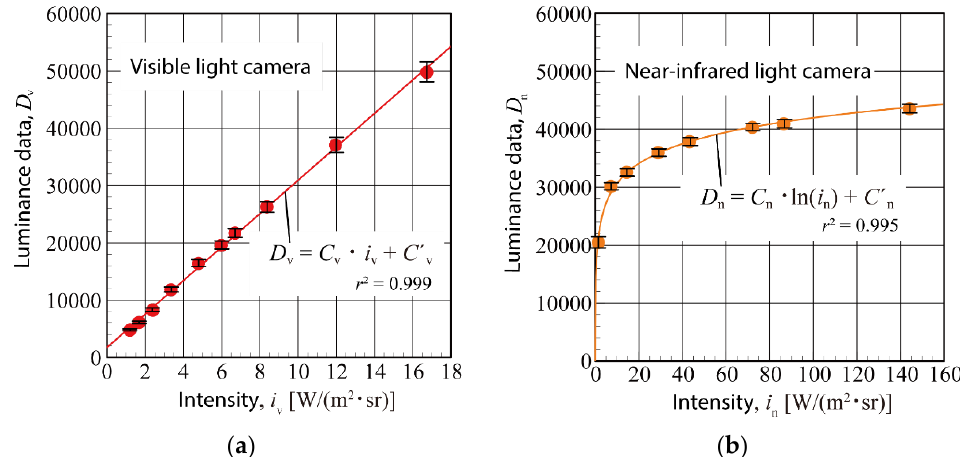
Figure 2. Measurement results for calibration experiment of ( a ) visible-light camera and ( b ) near- infrared light camera.